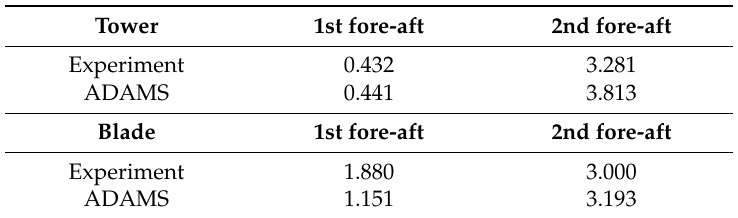
Table 4. Comparison of blade tower mode shape analysis.